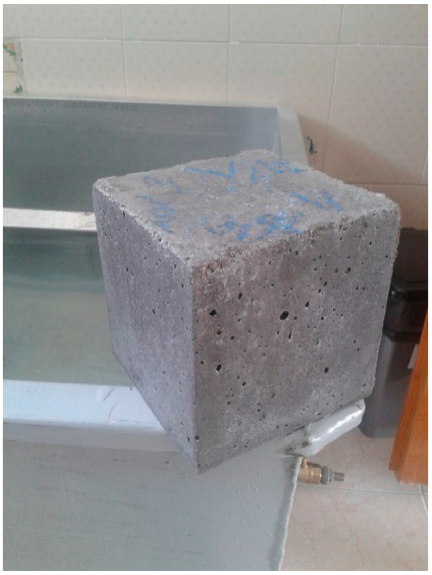
Figure 6: One of the normal concrete samples (without granite aggregates) after 24hours of curing in water.